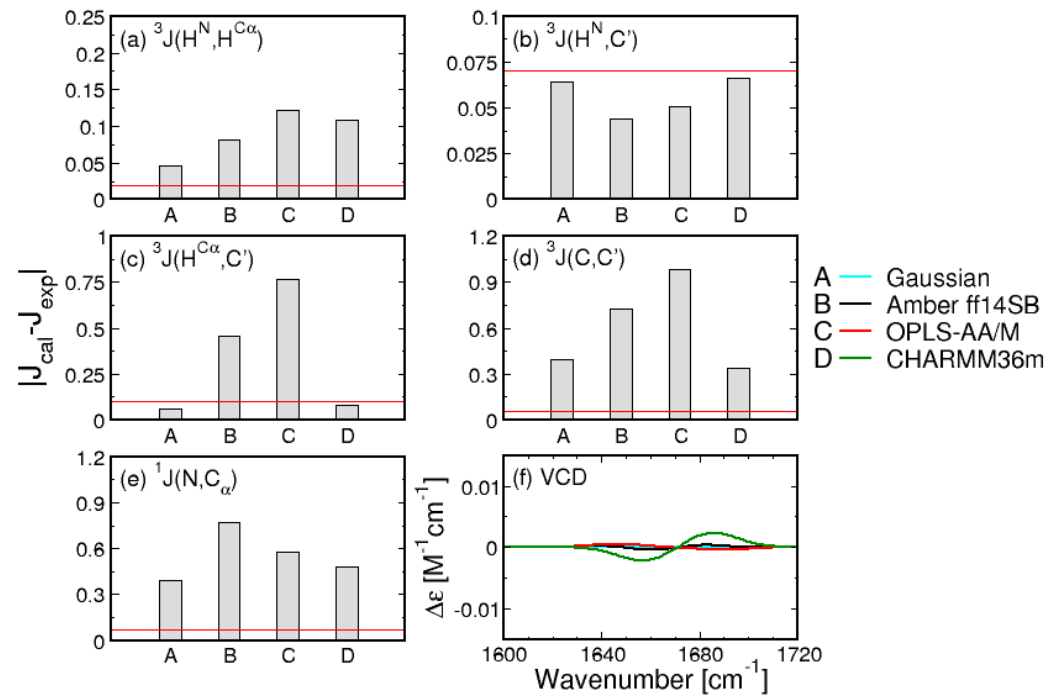
Figure 2. Comparison between experimental and calculated J-coupling constants. ( a – e ) absolute differences between calculated and experimental values of the five J-coupling constants for the Gaussian model and the three MD force fields. Red lines correspond to experimental uncertainties; ( f ) amide I’ profiles calculated from MD-derived Ramachandran